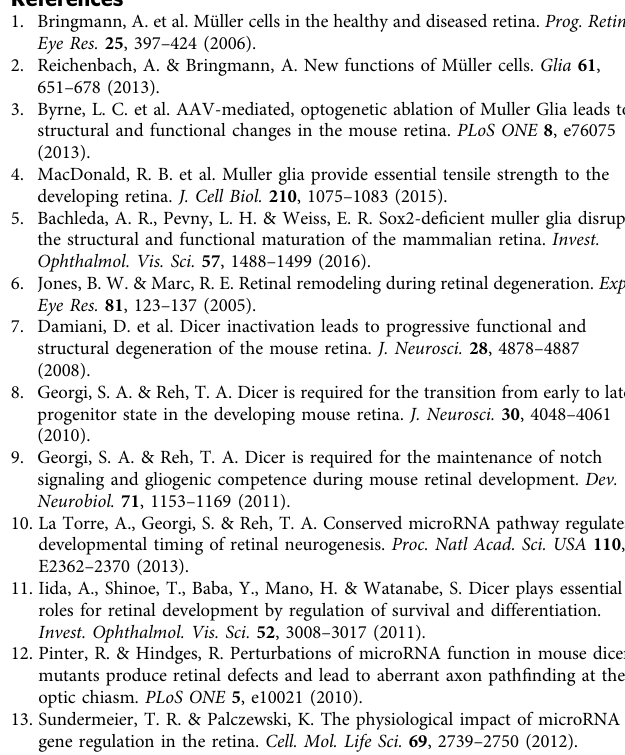
Supplementary Table 5. For miRNA RT-qPCR, cDNA stem-loop RT primers were used to produce cDNA for speci fi c miRNAs 67, 68 . Primers are shown in Supple- mentary Table 6. RT-qPCR was performed using SsoFast EvaGreen Supermix (Bio- Rad) on a Bio-Rad Thermocycler. Reactions were run in triplicates or duplicates for RT or – RT samples. Values were normalized to 5sRNA and/or β -actin. Delta delta